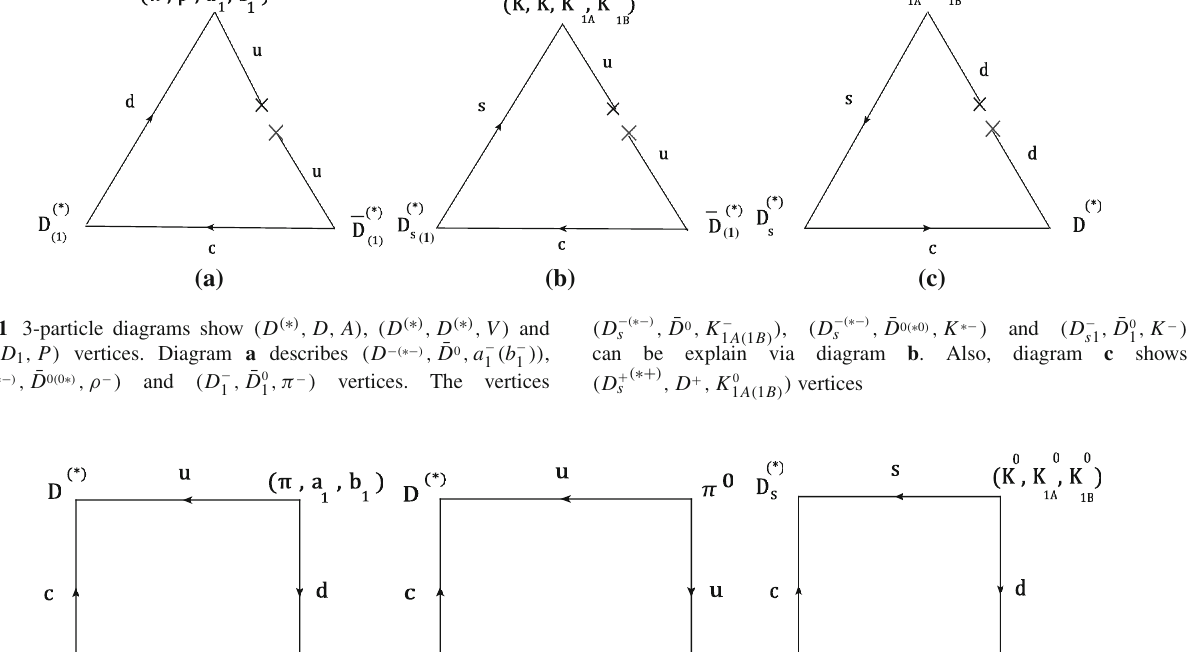
Fig. 2 4-particle diagrams show (ψ, D ( ∗ ) , D , P ) and (ψ, D ( ∗ ) D , A ) vertices. (ψ, D 0 ( ∗ 0 ) , D + ,π − ) and (ψ, D 0 ( ∗ 0 ) , D + , a − be explained via diagram a . (ψ, D 0 ( ∗ 0 ) , ¯ D 0 ,π 0 ) vertices are described via diagram b . Diagram c is used to explain (ψ, D + ( ∗+ )